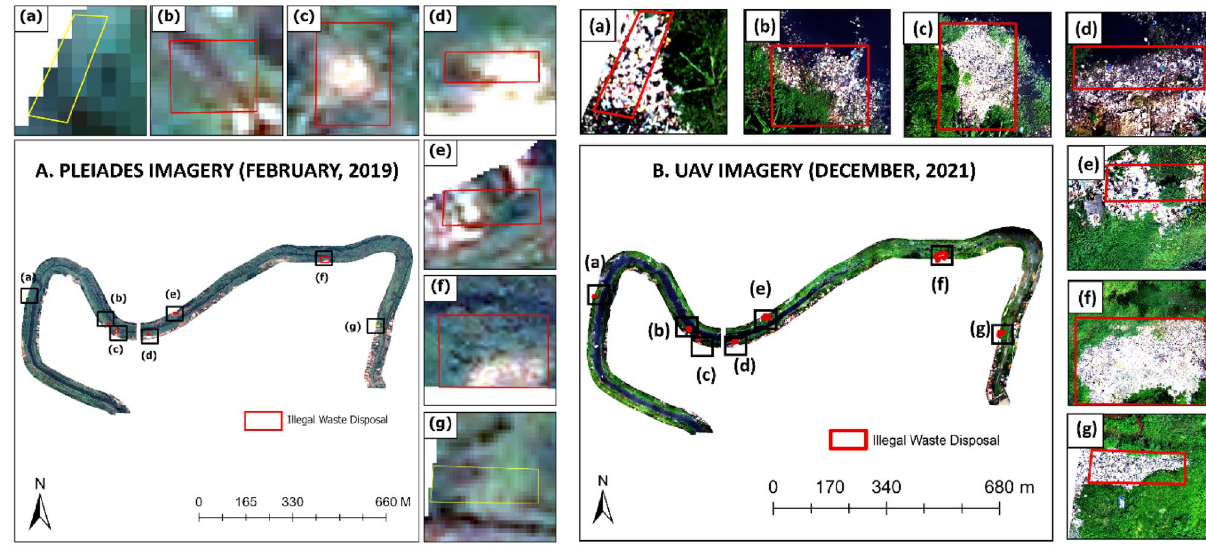
Figure 3. Seven illegal dumping areas were the target areas in this study: ( A ) Visualization results in the February 2019 with the Pleiades image, and ( B ) visualization results in December 2021 with the UAV photogrammetry